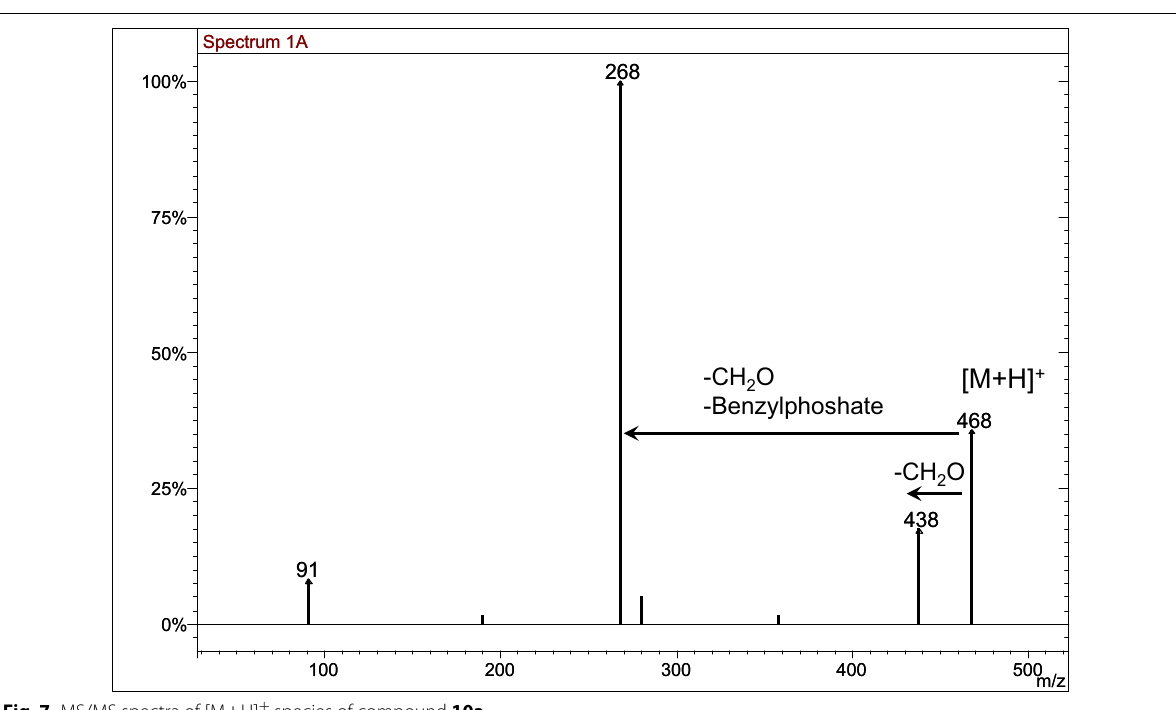
H] + species of compound +